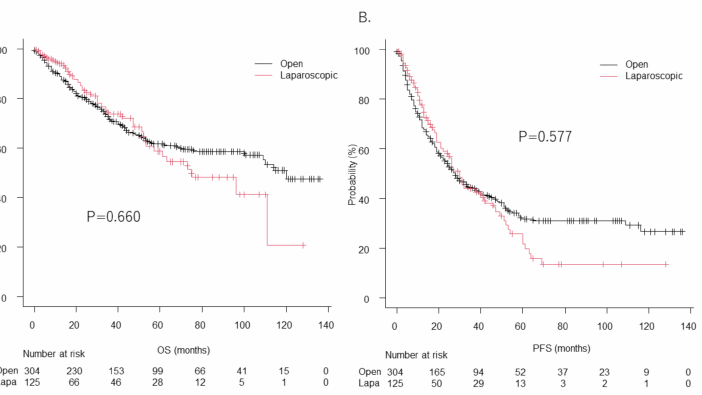
Figure 3. Overall survival (OS) ( A ) and progression-free survival (PFS) ( B ) in open and laparoscopic hepatectomy